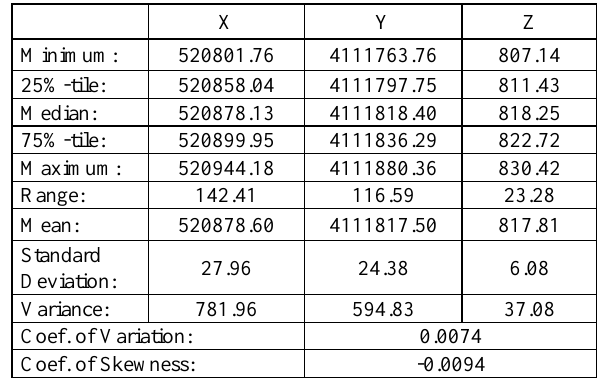
Figure 8. Point mesh obtained from the photogrammetric model Figure 10. Digital Elevation Model interpolated with a 10-cm grid Contours lines were obtained by intersection of the DEM and a set of 1-m interval parallel planes to the horizontal plane, and the information was exported to the dxf format (fig. 11).